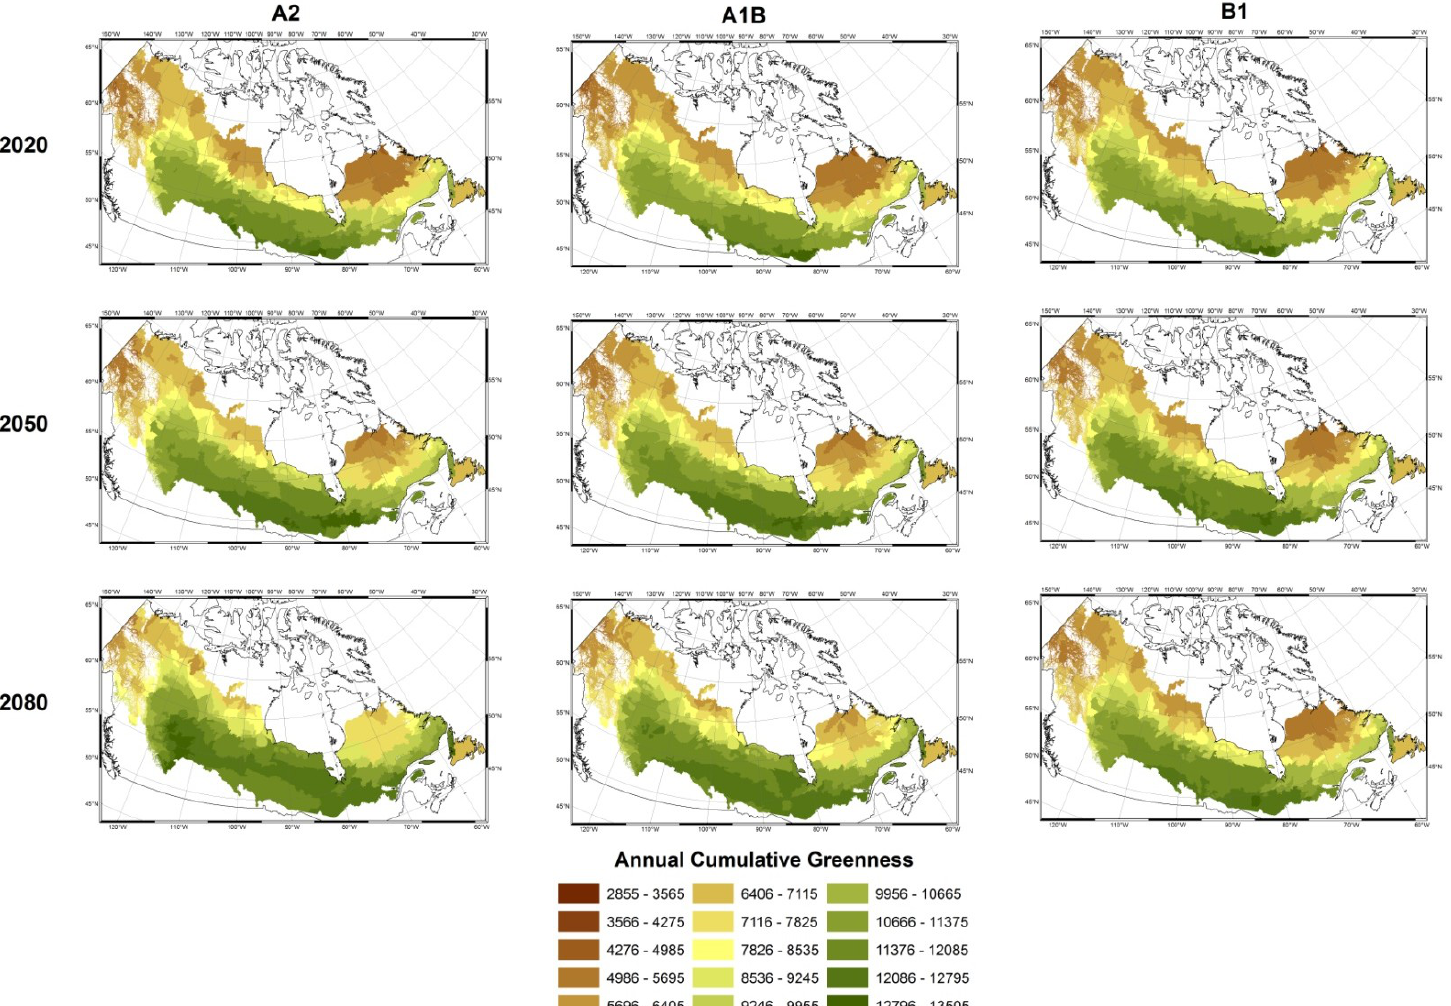
Figure 3. Predicted spatial distribution of annual cumulative greenness for 2020, 2050, and 2080 based on three Intergovernmental Panel on Climate Change (IPCC) climate change scenarios: A2 (most change), A1B (business as usual), and B1 (least